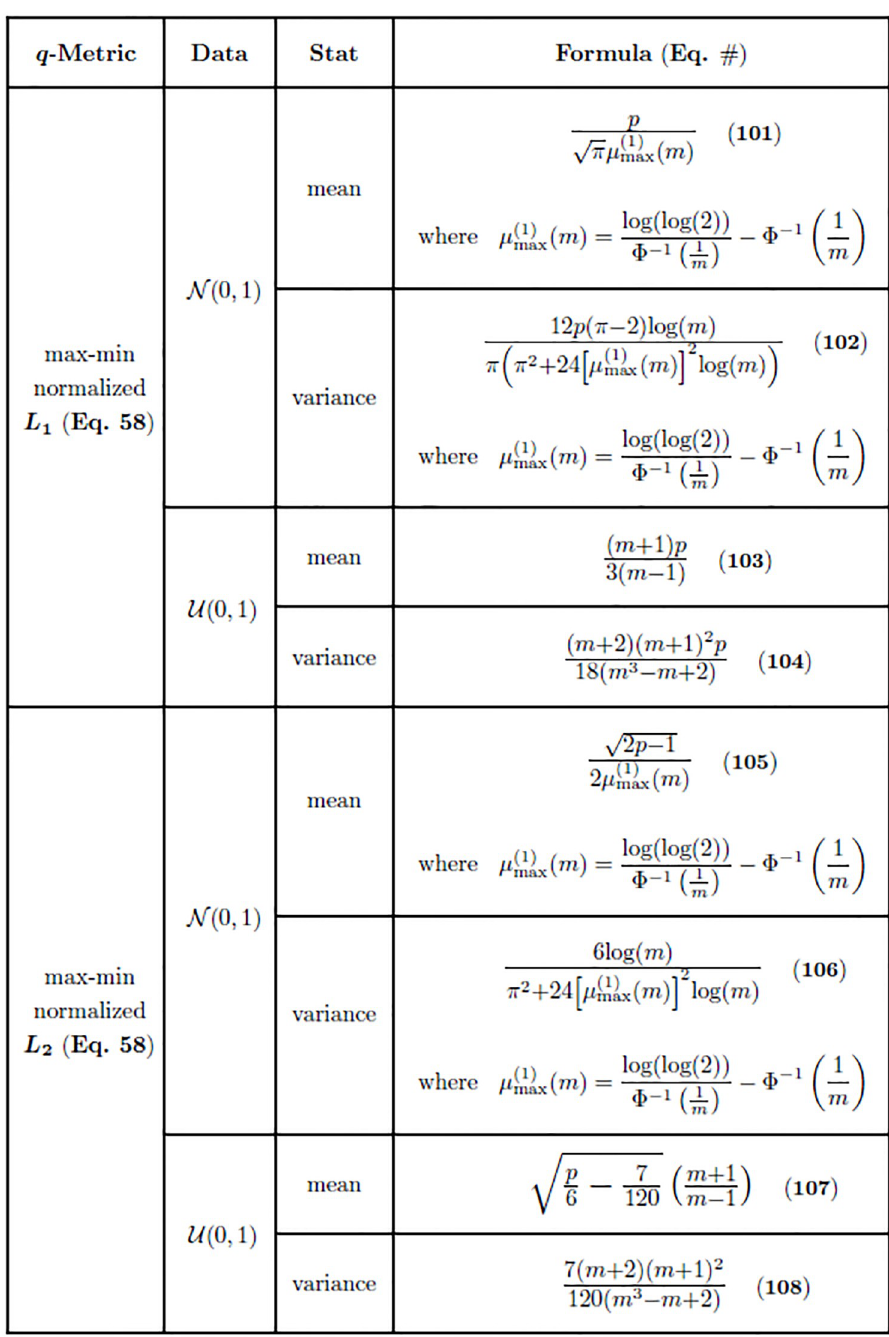
Fig 4. Asymptotic estimates of means and variances for the max-min normalized L 1 and L 2 distance distributions commonly used in Relief-based algorithms. Estimates for both standard normal ( N ð 0 ; 1 Þ ) and standard uniform ( U ð 0 ; 1 Þ ) data are given. The cumulative distribution function of the standard normal distribution is represented by F . Furthermore, m ð 1 Þ ð m Þ (Eq 86) is the asymptotic median of the sample maximum from m standard normal random max samples.